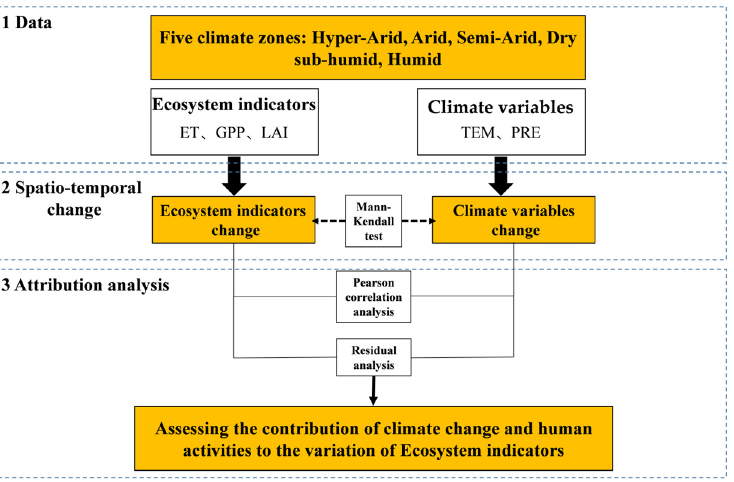
Figure 2. Technical flow chart.